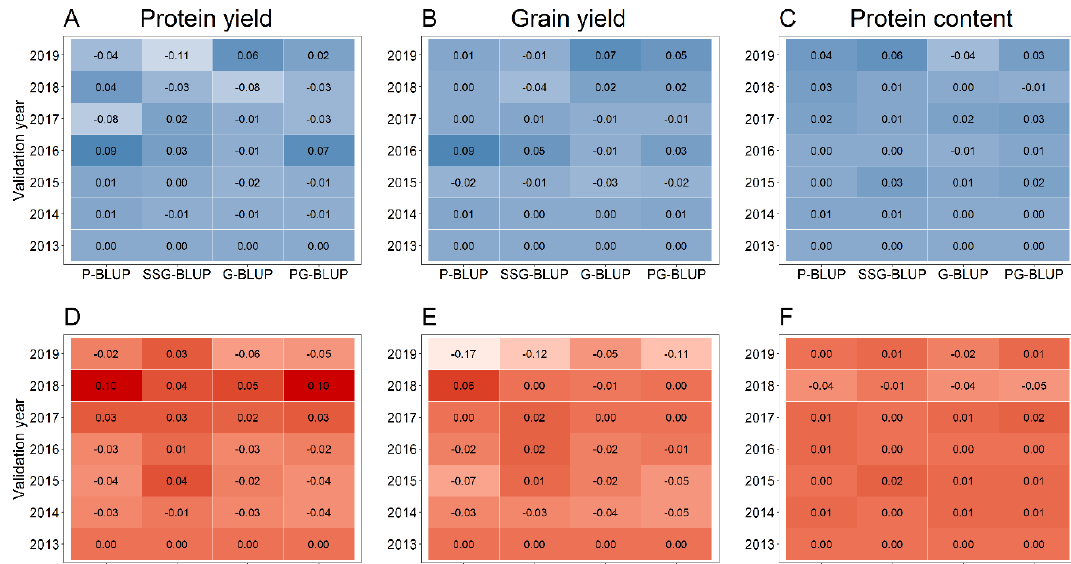
Figure 7. Difference in the prediction accuracy with (TP large ) or without (TP small ) augmenting the training population with lines tested in all preliminary yield trials preceding a validation year ( ∆ = r TP − r TP ) using pedigree-based (P-BLUP), single-step-based (SSG-BLUP), genomic-based (G-BLUP) and pedigree-genomic-based (PG-BLUP) forward predictions ( A – C ; blue coloured) as well as pedigree-assisted, single-step-assisted, genomic-assisted and pedigree-genomic-assisted forward predictions with the latter exploiting preexisting information of the validation population from preliminary yield trials ( D – F ; red coloured). A darker colouring generally indicates an advantage for augmenting the training population with lines tested in all preliminary yield trials preceding a validation year.